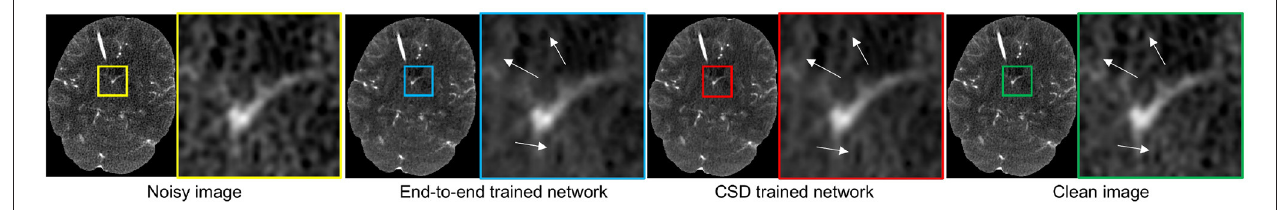
FIGURE 3 | The visual comparison of the denoising performance between the network trained with end-to-end and the one trained with our CSD